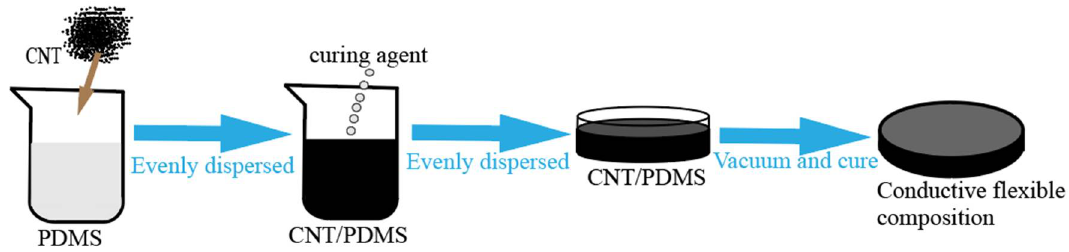
Figure 2. Processing of CNT/PDMS force-sensitive structure.